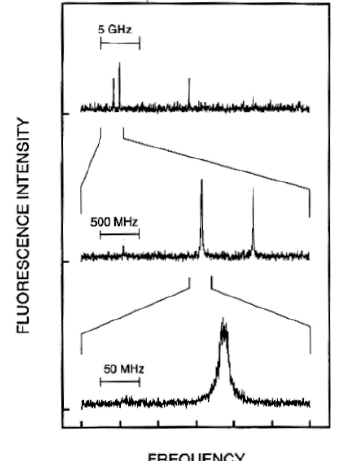
Fig. 1. Example of a single-molecule fluorescence excitation spectrum showing the lifetime-limited lines of single pentacene molecules in a p-terphenyl crystal at 1.8 K (from Ref.